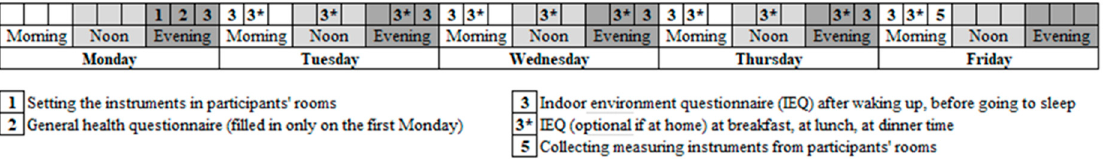
Figure 2. Week 1—Events schedule (**Each volunteer participated three non-sequential weeks).